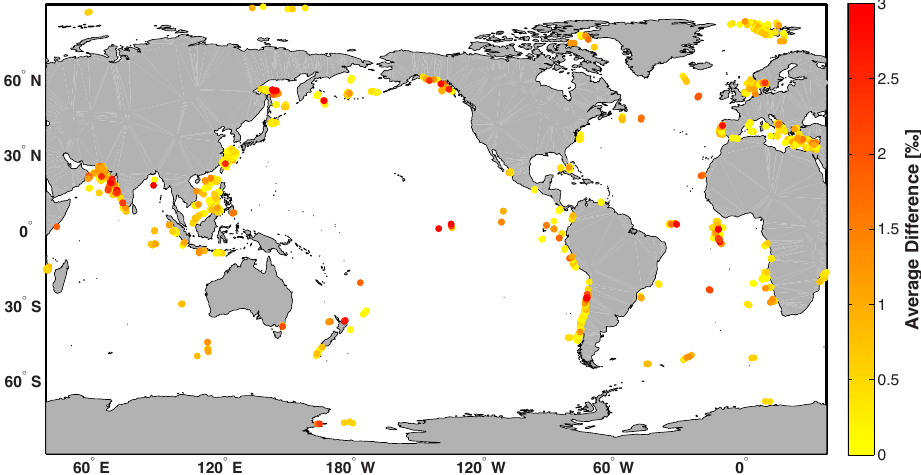
Fig. 2. Map of seafloor samples indicating the difference between the δ 15 N of the sample and the mean δ 15 N of its neighbours (within a 100km radius). The differences are small for most of the available locations. Data points with larger differences are plotted on top of those with smaller differences, to highlight regions where high spatial variability